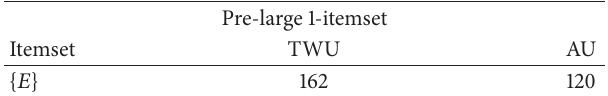
Table 11: The filtered pre-large transaction-weighted utilization itemsets by sliding